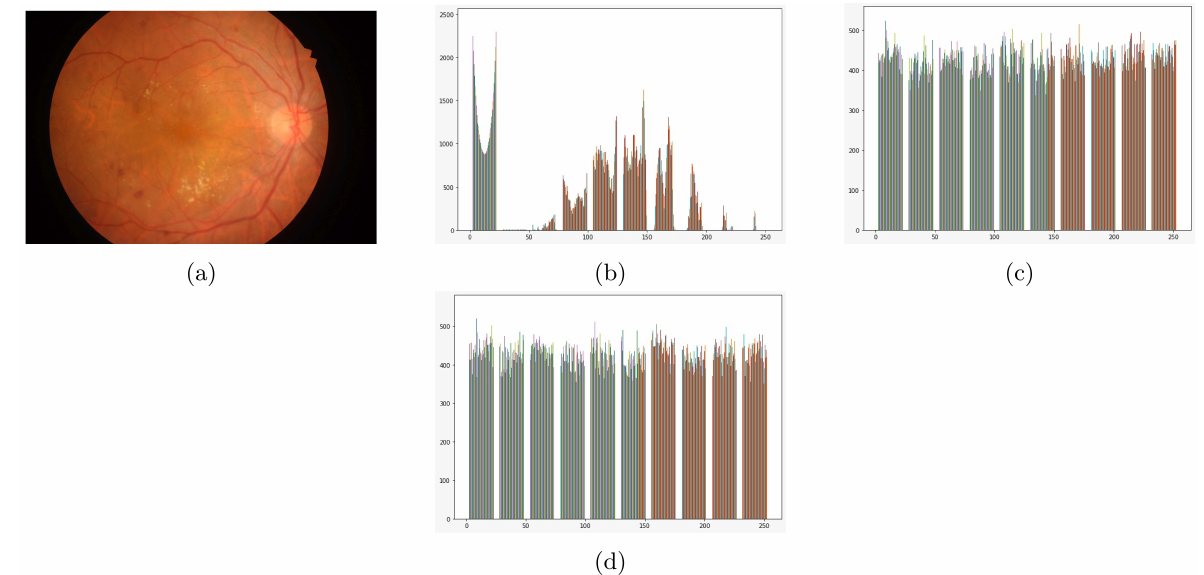
Figure 11. Histogram graph. ( a ) Original Image, ( b ) image histogram, ( c ) Histogram for the XORed image with the Trivium, and ( d ) Histogram for the encrypted